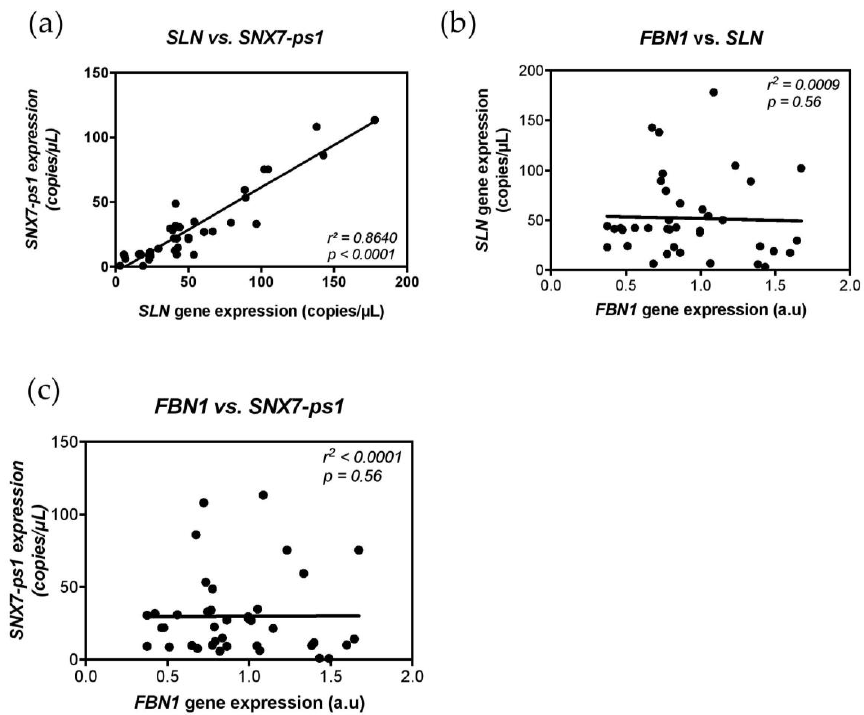
Figure 2. Correlation of expression levels between FBN1 SLN and SNX7-ps1 gene. ( a ) Gene expression levels were assessed using digital droplet PCR (ddPCR). Positive correlation of expression was observed between the nearest gene of the lead SNP, SLN and SNX7-ps1 ( r 2 = 0.86, p -value < 0.0001). ( b ) Correlation plot between FBN1 and SLN expression. No correlation was found ( r 2 = 0.0009, p -value = 0.56). ( c ) Correlation plot between FBN1 and SNX7-ps1 expression. No correlation was found ( r 2 < 0.0001, p -value = 0.56).